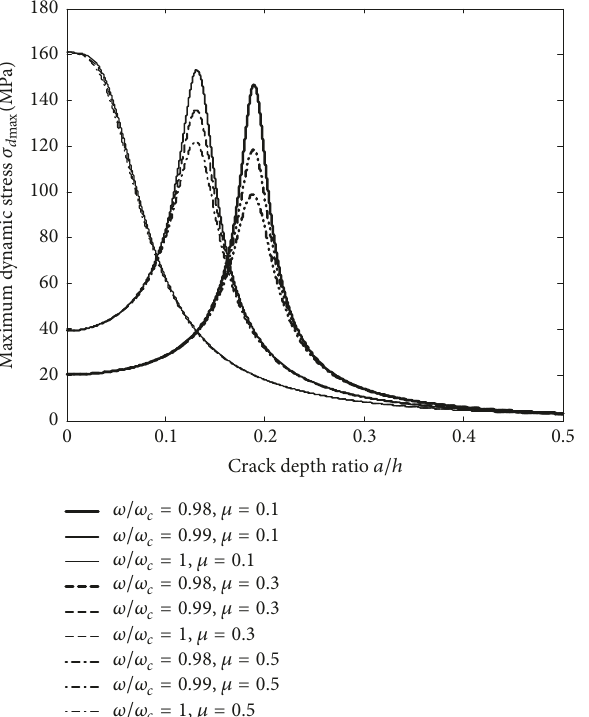
Figure 10: The maximum dynamic stress with crack severity change of breathing cracked beam.